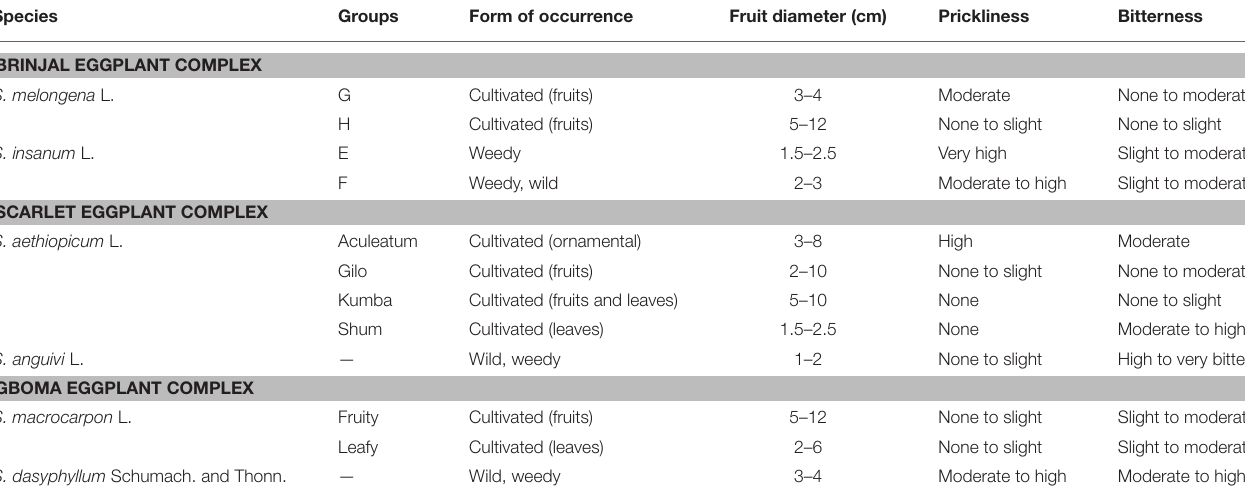
TABLE 1 | Cultivated eggplants (brinjal eggplant, S. melongena L.; scarlet eggplant, S. anguivi L.; gboma eggplant, S. macrocarpon L.) and their wild relatives from the primary genepool, which correspond to their wild ancestors ( S. insanum L. for brinjal eggplant, S. anguivi for scarlet eggplant, and S. dasyphyllum for gboma eggplant) (Lester, 1986; Lester and Niakan, 1986; Bukenya and Carasco, 1994; Schippers, 2000; Daunay et al., 2001; Weese and Bohs, 2010; Meyer et al., 2012; Knapp et al., 2013; Vorontsova and Knapp, 2016). Species Groups Form of occurrence Fruit diameter (cm)